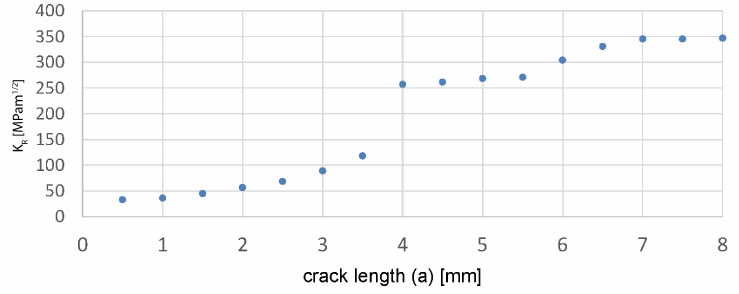
Figure 12. K R based on ASTM E399- values for each step of the crack opening calculated following the large samples as shown in Figure